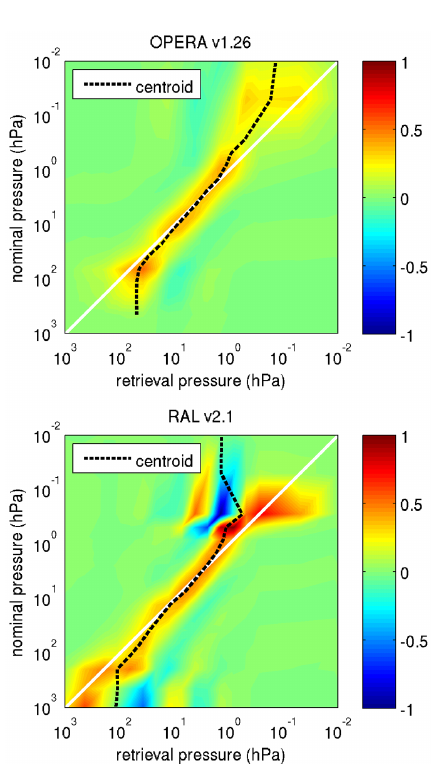
Figure 3. Illustrative relative averaging kernel matrix representa- tions with indication of centroid position (see Sect. 5.3) for OPERA v1.26 and RAL v2.1 retrievals from the first GOME-2 2008 mea- surement over Uccle (Belgium, January 2,